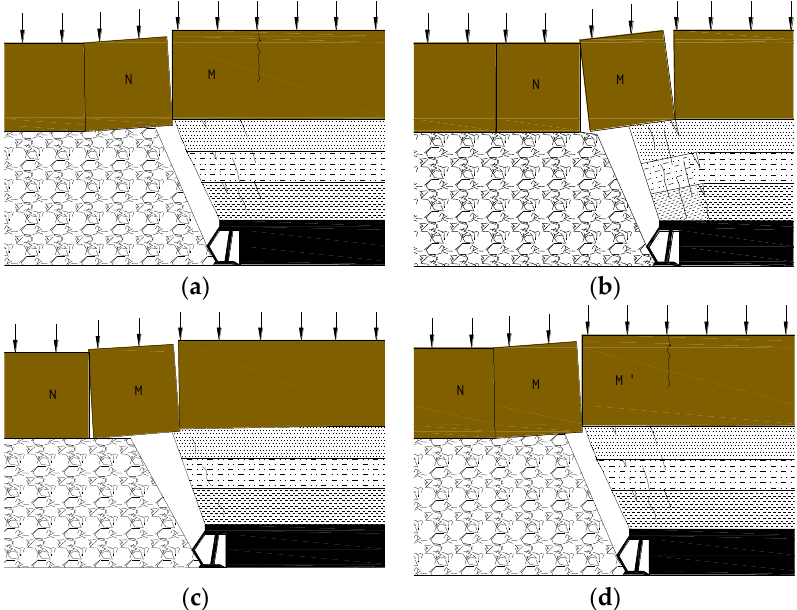
Figure 10. Structural evolution process of “step rock beam” in shallow buried large mining height: ( a ) before weighting; ( b ) starting weighting; ( c ) weighting time; ( d ) after weighting.